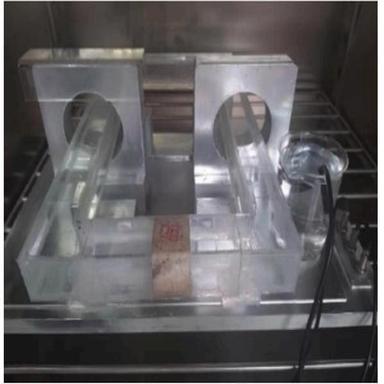
The Device diagram of NC-ERM.